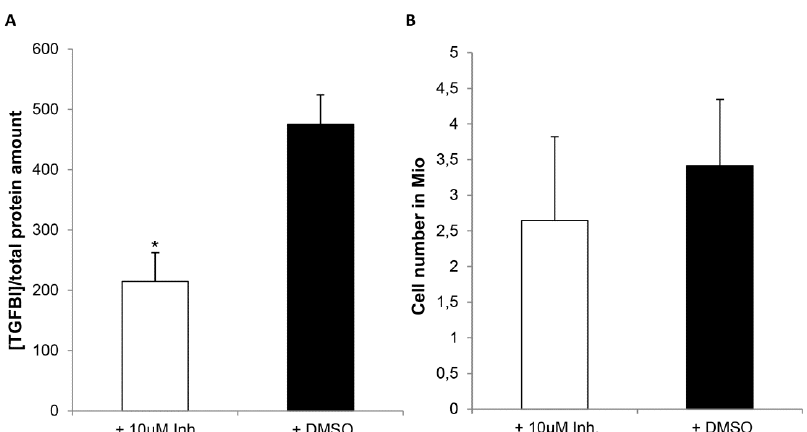
Figure 6. Wound closure assay 5637 cells. Representative images of 5637 scratch assays showing cells transfected with TGFBI siRNA and control siRNA, 0 h and 24 h after the wound was made ( A ). Accompanying quantification calculated as a percentage of wound closure in TGFBI siRNA-transfected cells compared to the negative control ( B ). Results are displayed as mean +SD ( n = 3, * p < 0.026; ** p < 0.0009). Images were taken using a 4× objective; bar 200 µm.